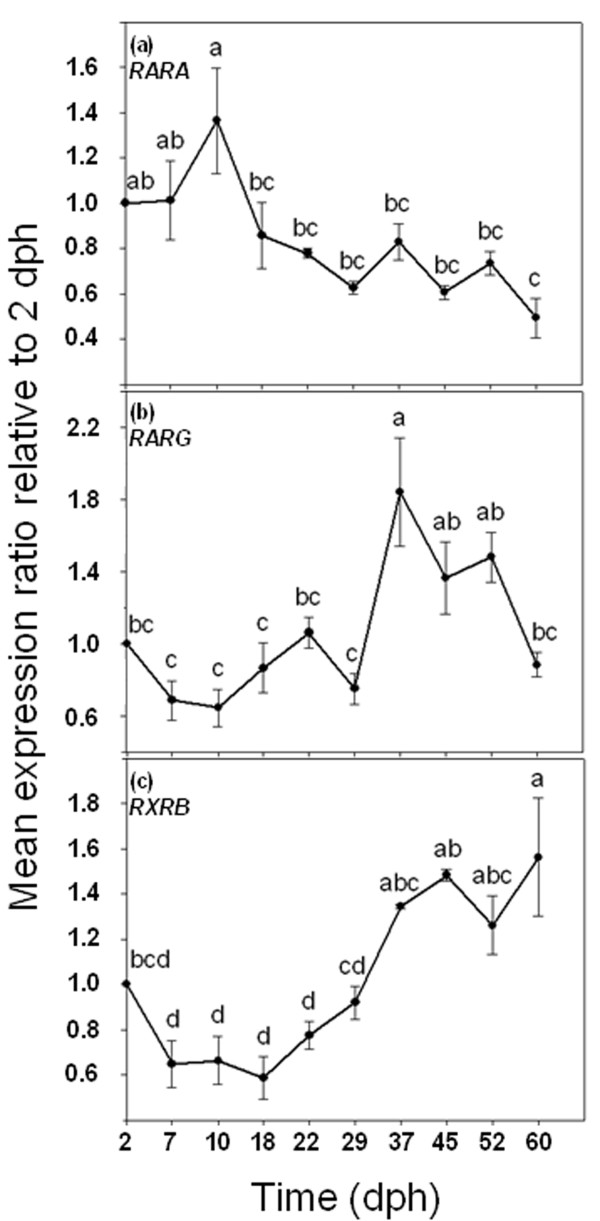
Ontogenetic gene expression patterns of RARA (a), RARG (b) and RXRB (c). Gene expression measured as the mean expression ratio of the target gene with respect to the house-keeping gene (EF1α) at each sample time compared with initial sample time (2 dph). Different letters denote significant differences of the global gene expression (ANOVA, P < 0.05; n = 3).